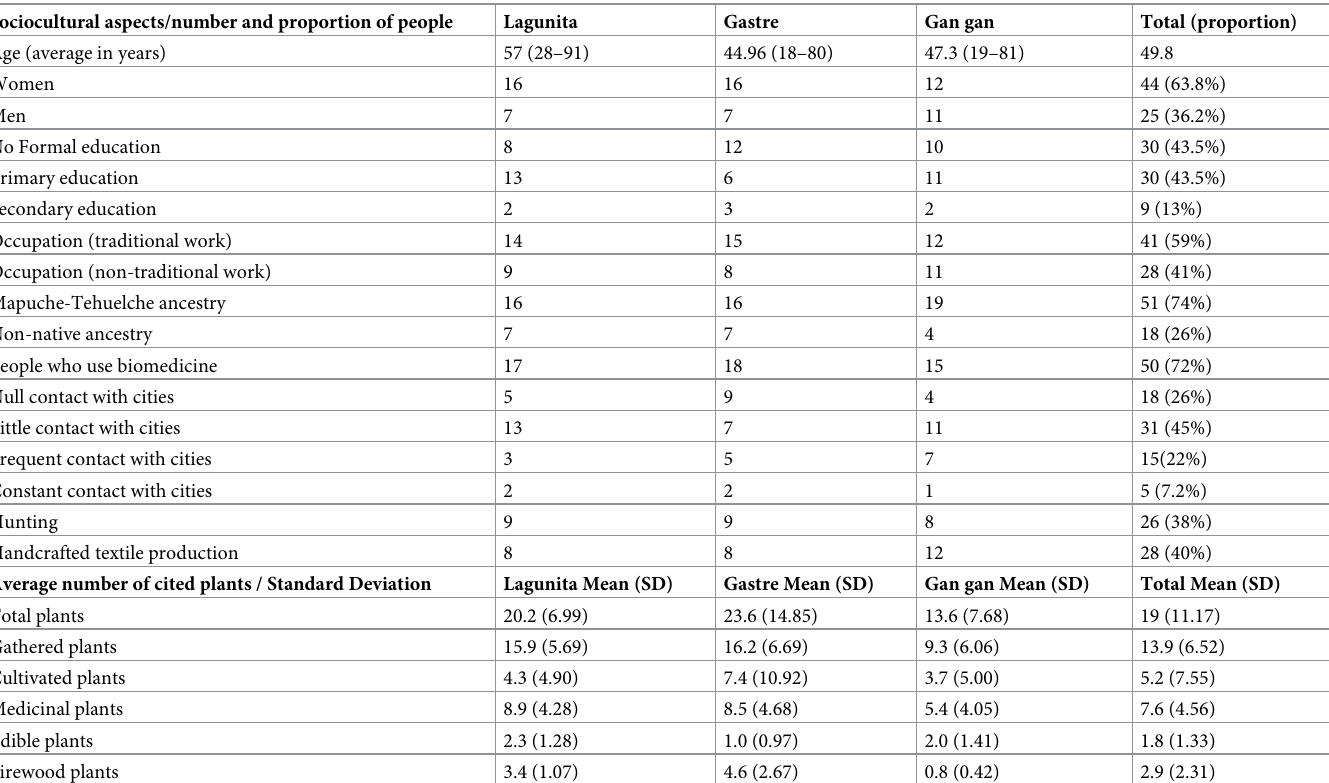
Table 1. Number and proportion of people of each community for each sociocultural aspect and average number of cited plants with standard deviation